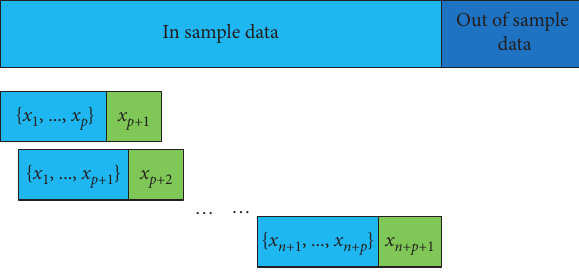
Figure 5: Data partitioning diagram. Table 2: The forecasting results of the original data.